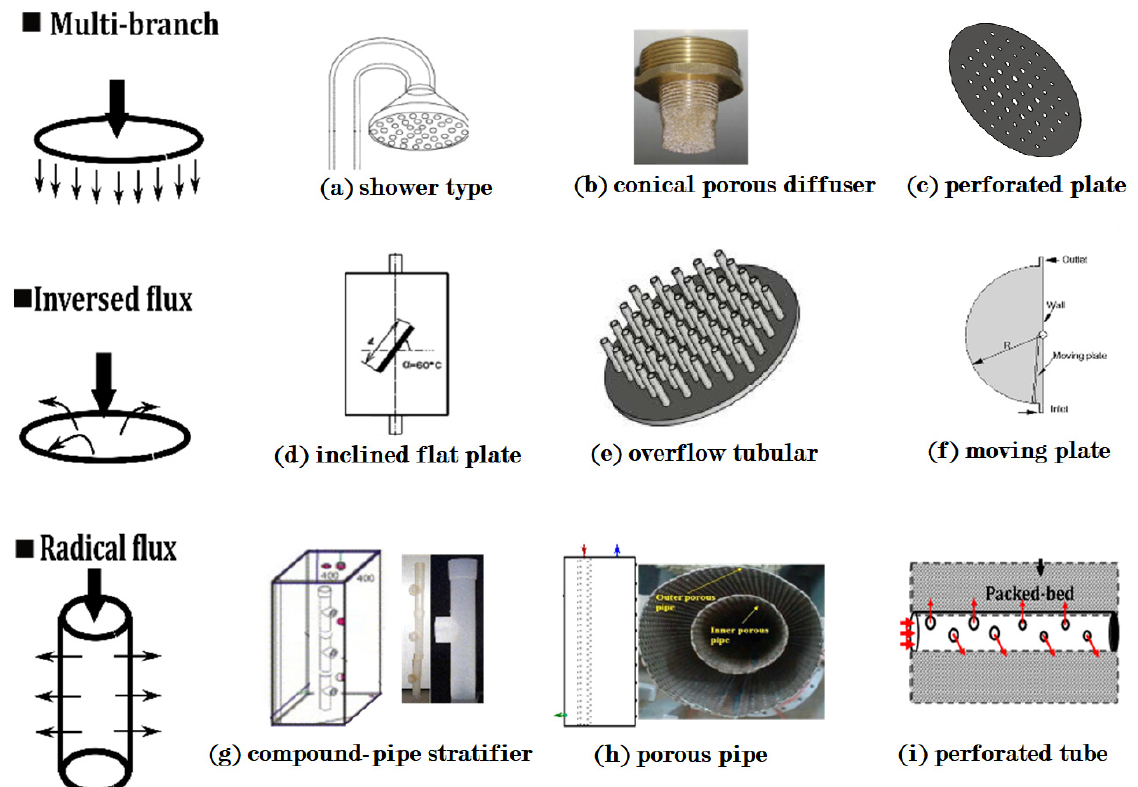
Figure 6. Classification and examples of flow distributor used in thermocline TES tank. ( a ) shower type [66]; ( b ) conical porous diffuser [20]; ( c ) perforated plate [67]; ( d ) incline flat plate [14]; ( e ) overflow tubular [67]; ( f ) moving plate [68]; ( g ) compound-pipe stratifier [69]; ( h ) porous pipe [70]; ( i ) perforated tube [71]. Reprinted with permission from refs. [14,20,67–71]. 4 October 2021 , Elsevier.